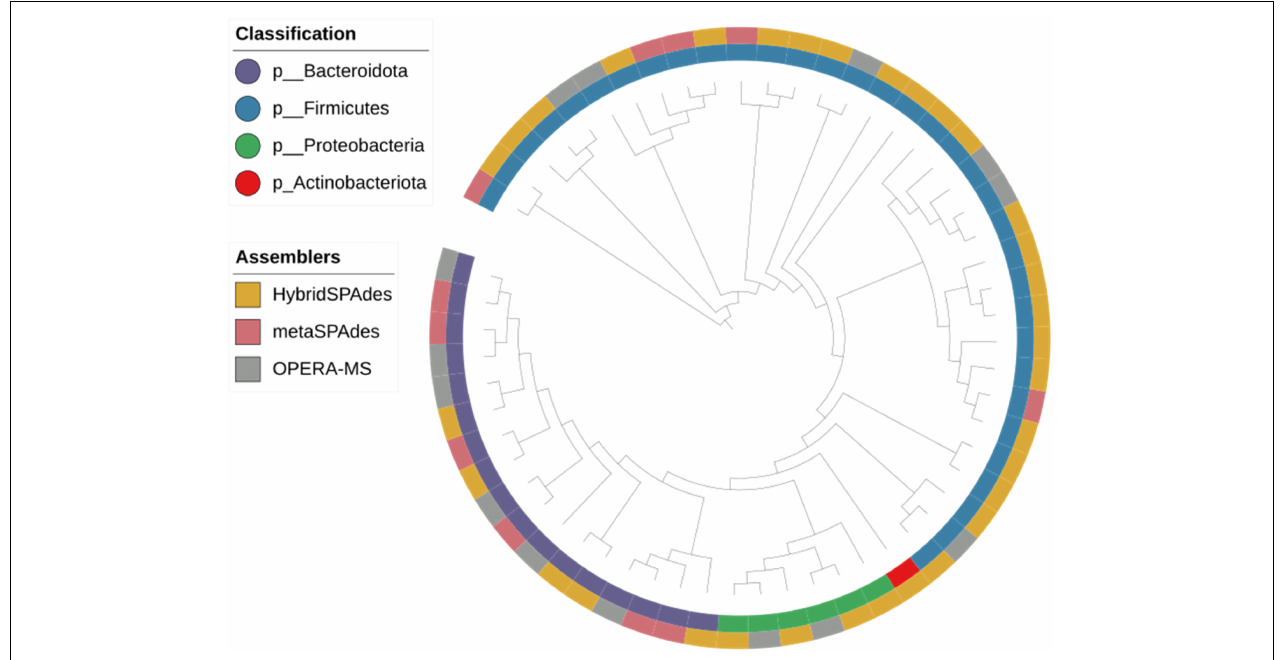
FIGURE 6 | Phylogeny of the genome bins reconstructed from dereplication of metagenome assembly with different algorithms. Phylum of the strains and assemblers are plotted in the figure.